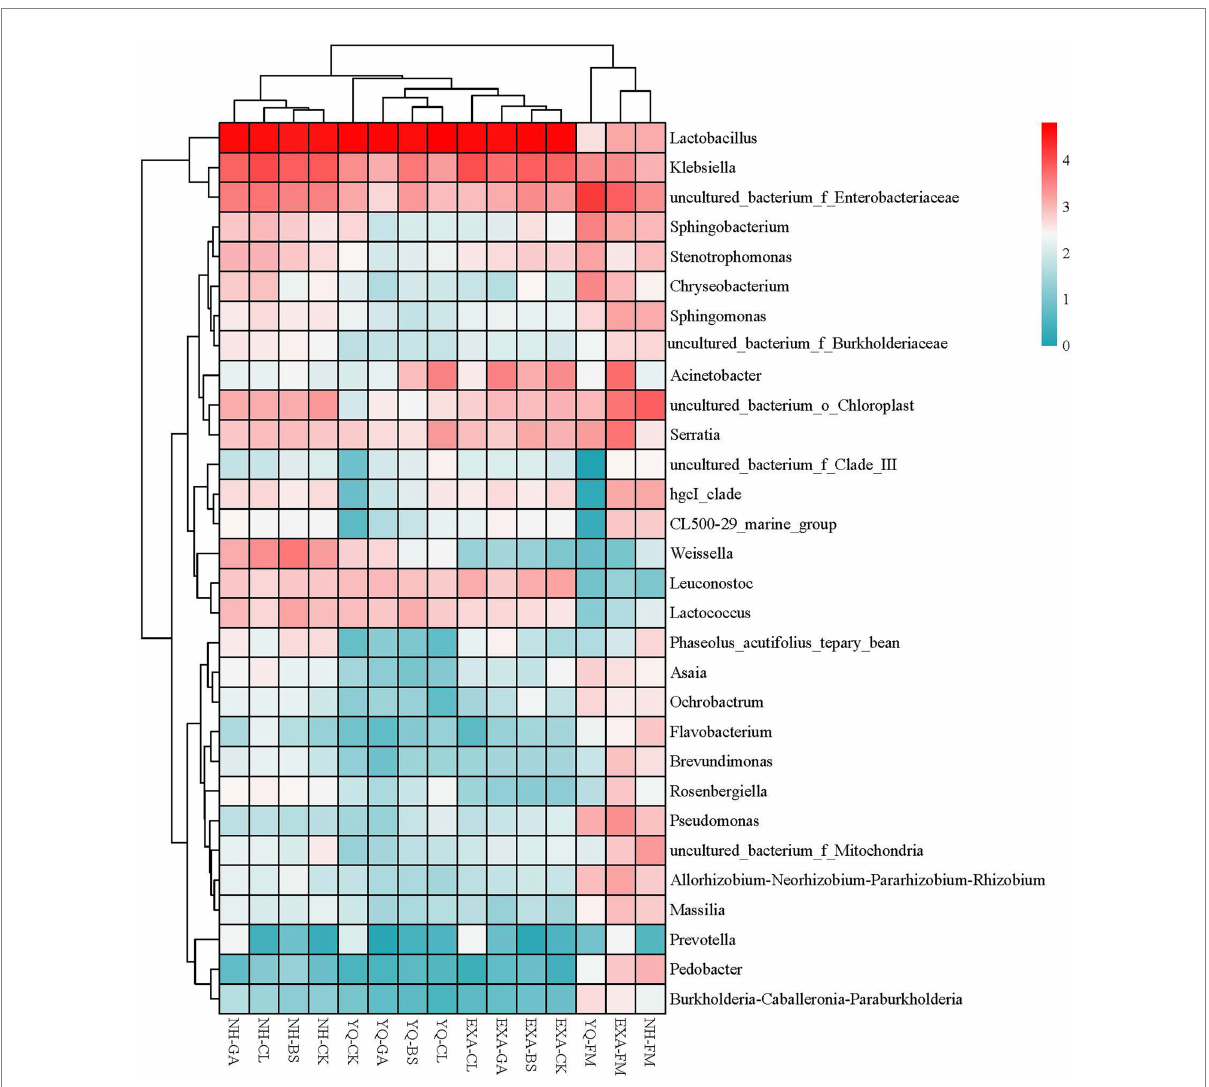
FIGURE 5 Community heat map of bacterial genera for whole-plant corn silage with different treatments. YQ, corn variety Yuqing 386; EXA, corn variety Enxiai 298; NH, corn variety Nonghe35; FM, fresh raw materials; CK, no additives; BS, 0.02% Bacillus subtilis CP7 of FM; GA, 0.2% gallic acid of FM; CL, 0.02% cellulase of